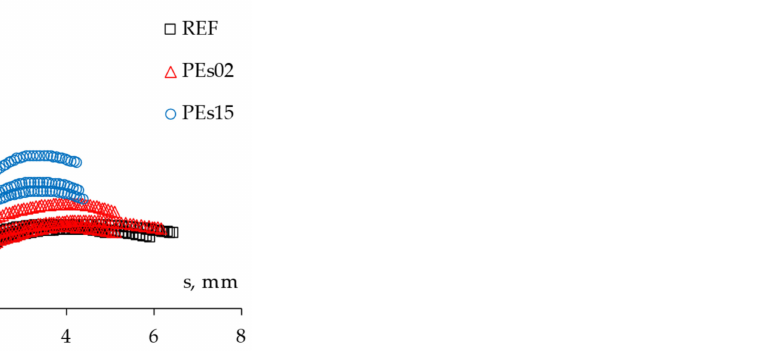
Figure 16. The comparison of the force–displacement trends from the ITS tests (all